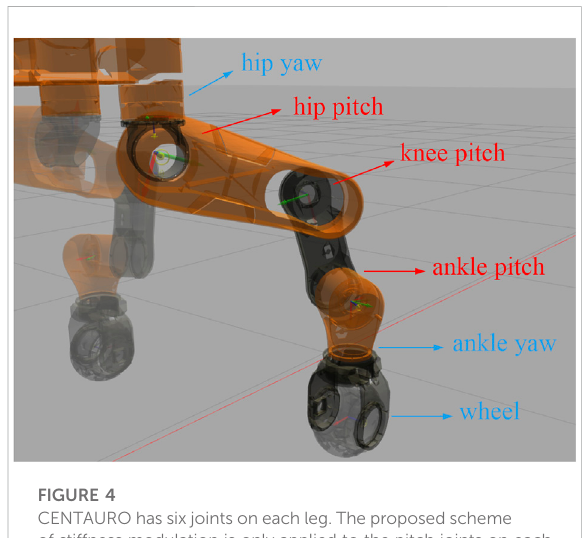
FIGURE 4 CENTAURO has six joints on each leg. The proposed scheme of stiffness modulation is only applied to the pitch joints on each leg in our experiments, i.e., those marked by red